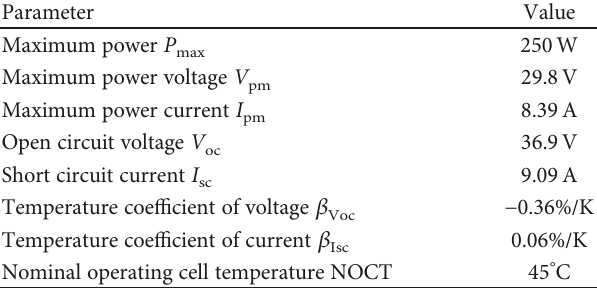
Table 1: Parameters of the PV modules used in